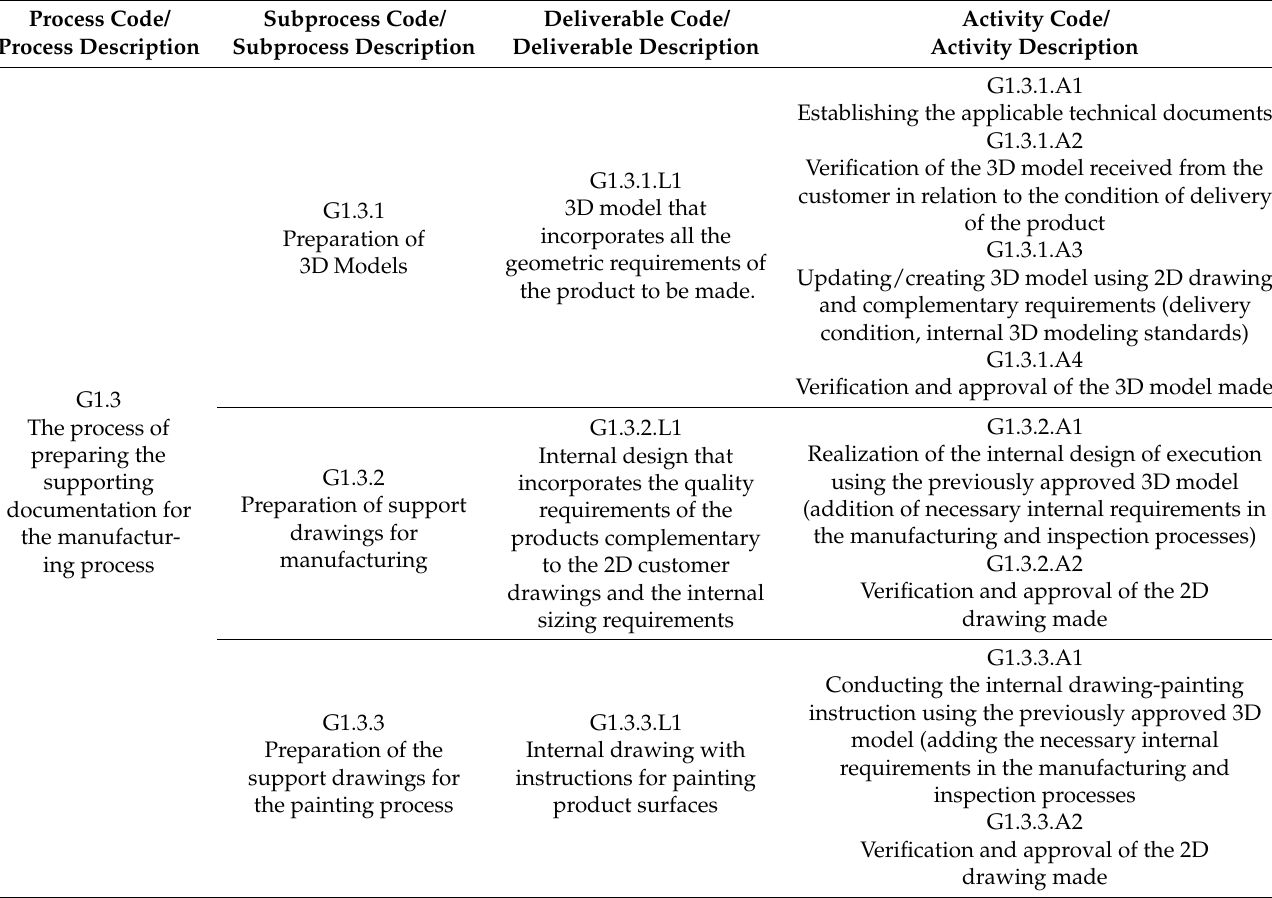
Table 2. Description of the activities of process groups G1.3 and